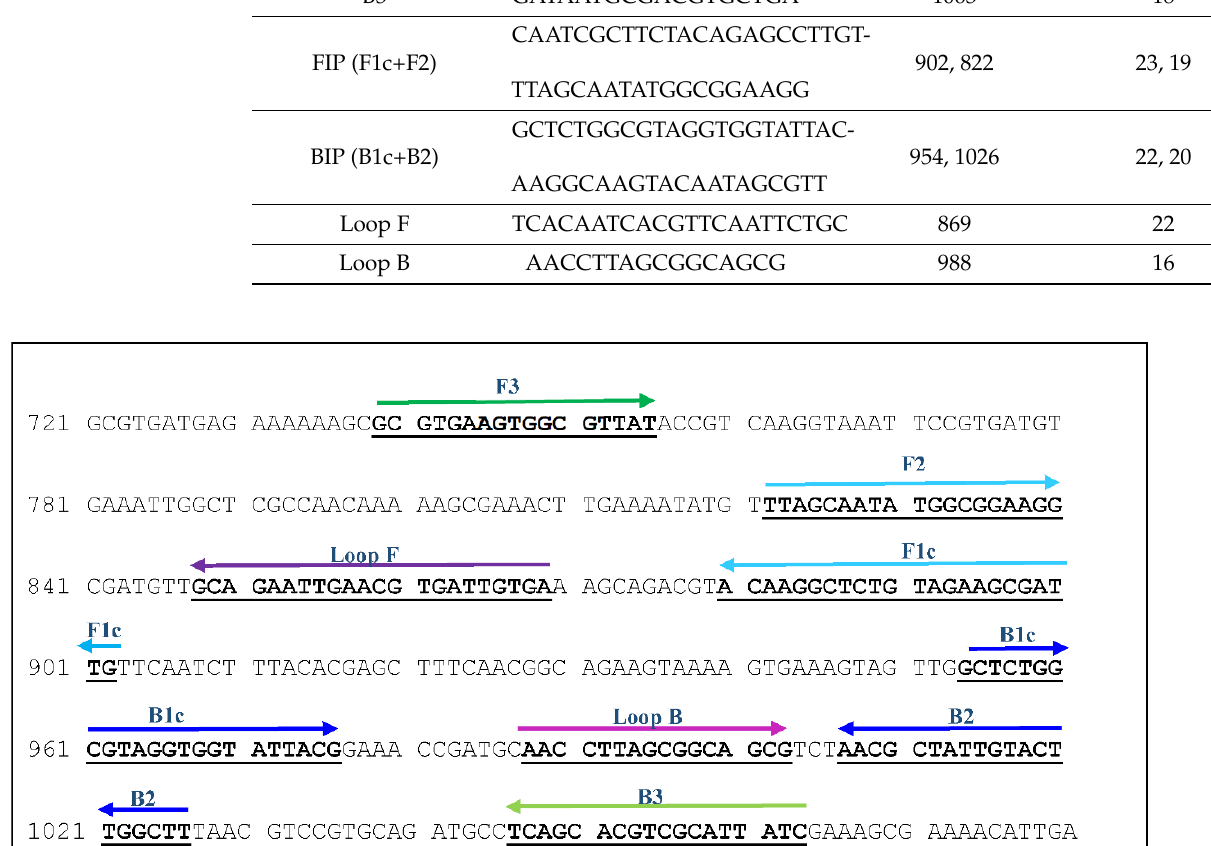
Table 2. Most suitable primer set used for the LAMP assay targeting the infB gene.